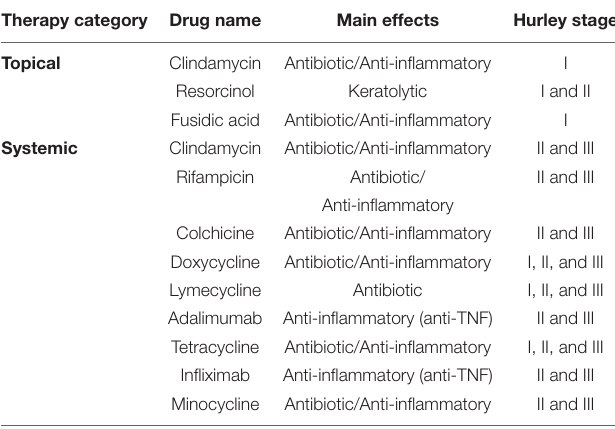
TABLE 1 | List of therapeutic categories and examples of available drugs with their main effect and indication to specific stages considering the Hurley stage